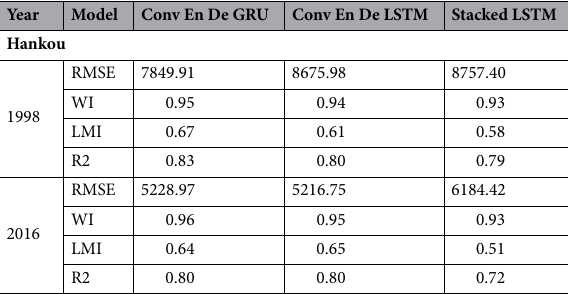
Table 3. Comparison of criteria with different models in Hankou